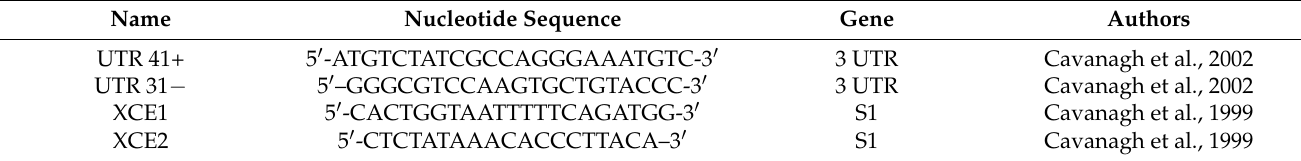
Table 1. General information of primers used for 3 (cid:48) UTR detection and S1 gene